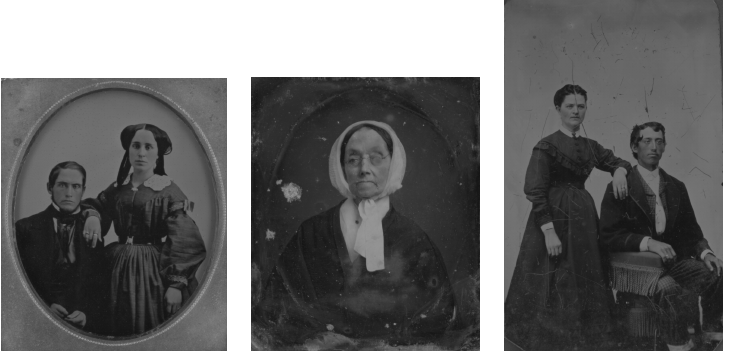
Figure 12. Grayscale images of ambrotype, daguerreotype, and tintype scanned in LRFB